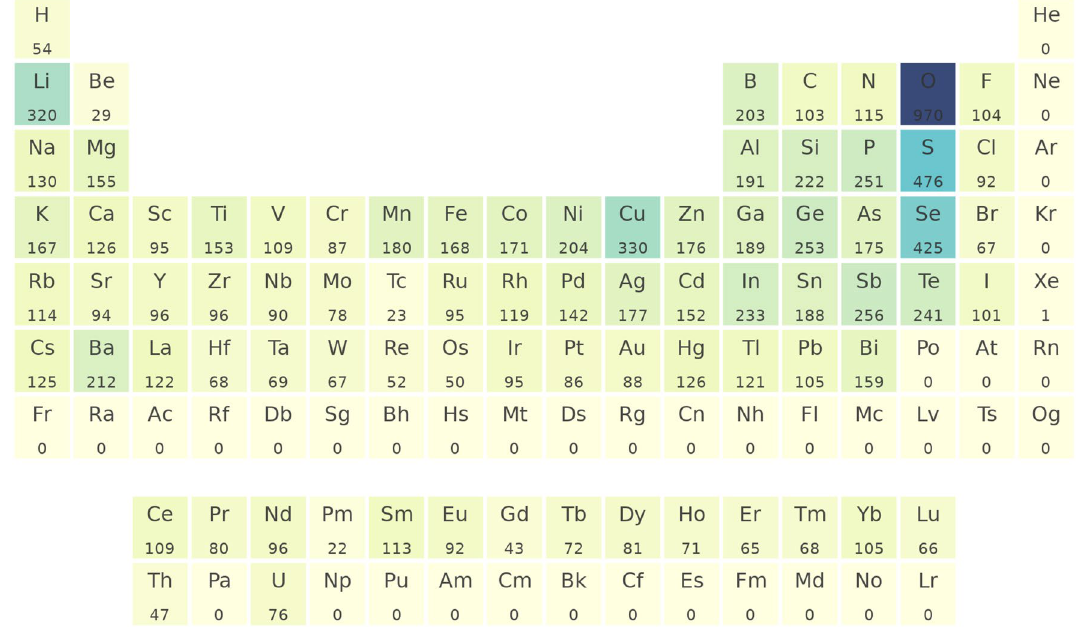
Figure 1. The periodic table outlining frequencies of the elements occurring in our band gap dataset. The color represents the frequency of occurrence. This frequency is also labeled under each element